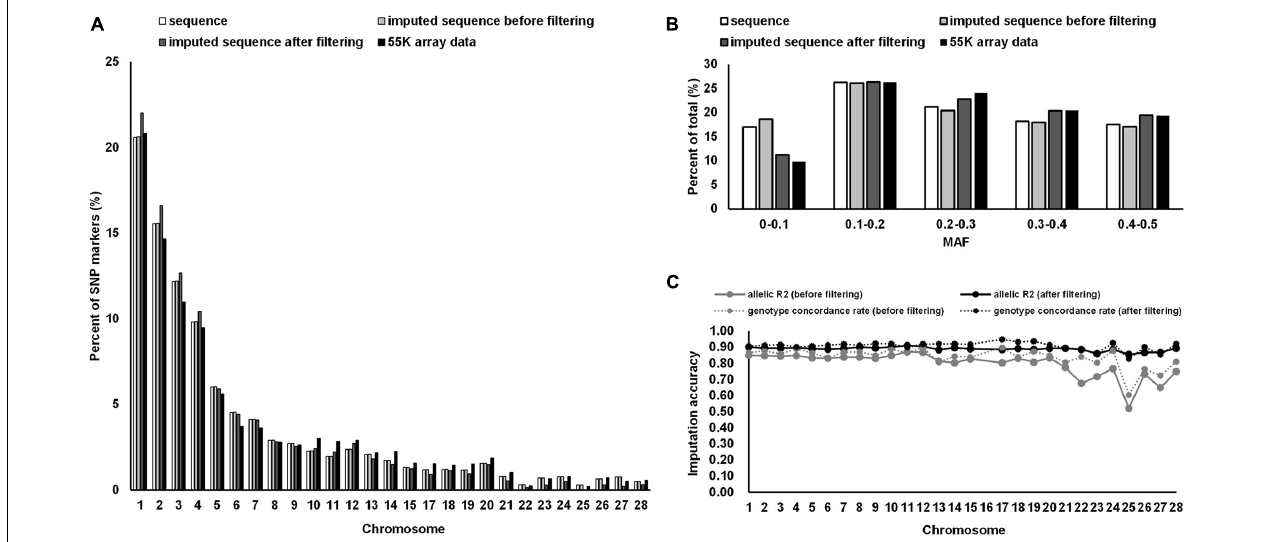
FIGURE 1 | Distribution of SNP markers and imputation accuracy. (A) Percentage of SNPs on the chromosome for the 55 K array data of 873 birds, WGS data of 230 birds, and imputed WGS data of 873 birds after imputation and post-imputation filtering. (B) Percentage of SNPs in each MAF class for different datasets. (C) The imputation accuracy of the imputed WGS data of 873 birds after imputation and post-imputation filtering. MAF, minor allele frequency.